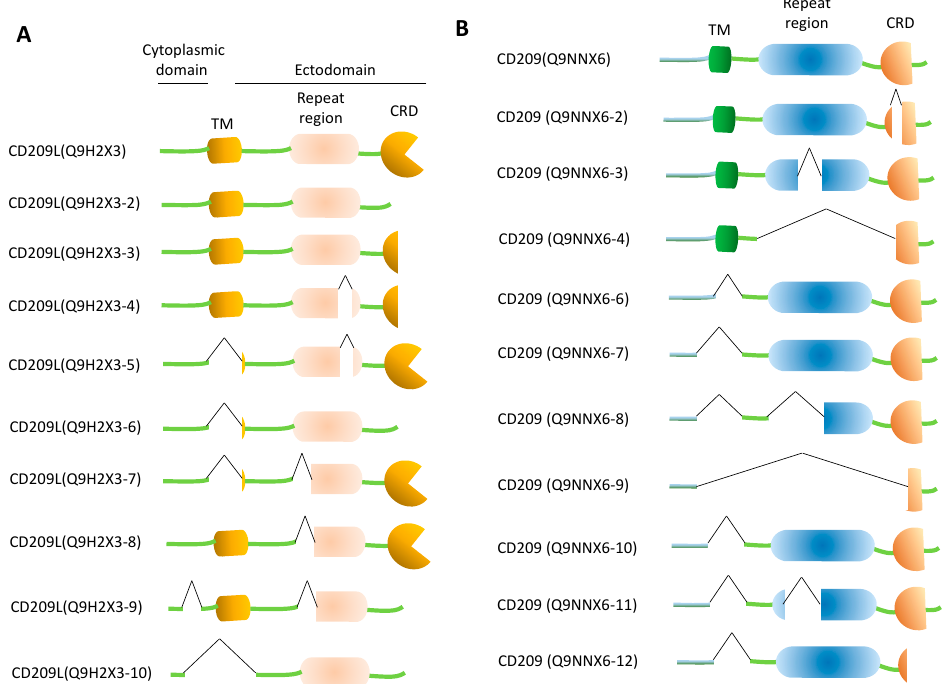
Figure 3. The schematics of alternatively spliced variants of CD209L and CD209. Amino acid sequences of alternatively spliced variants of CD209L ( A ) and CD209 ( B ) were aligned via Clustal Omega software program. The schematic of each alternatively variant proteins were presented .